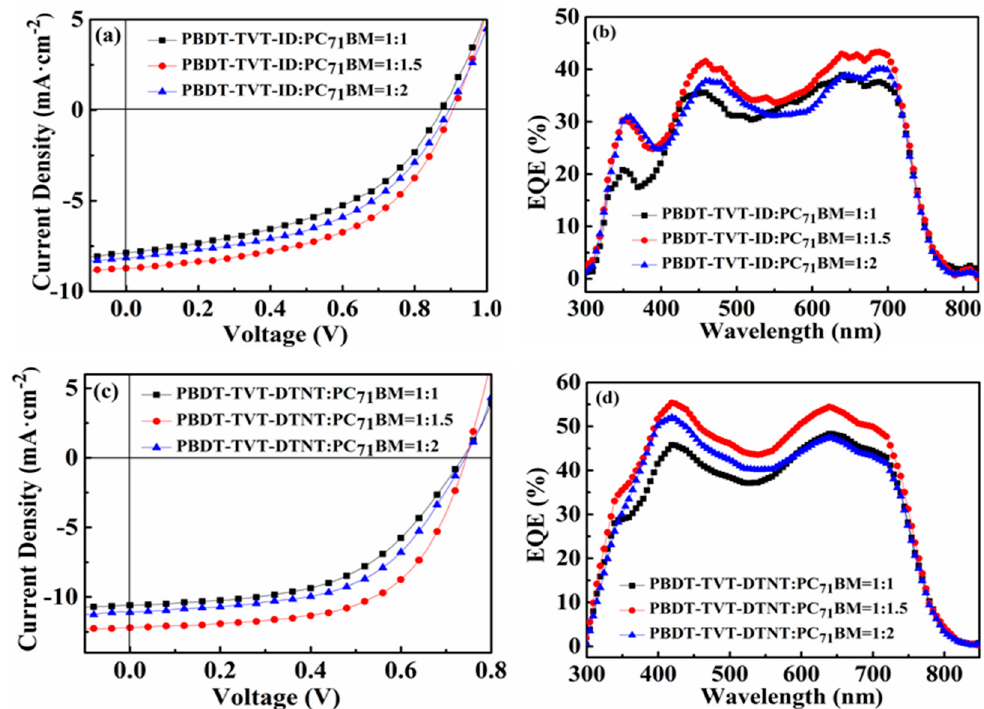
Figure 6. ( a , c ) J - V curves of the PSCs based on PBDT-TVT-ID and PBDT-TVT-DTNT; ( b , d ) EQE spectrums of the related PSCs.